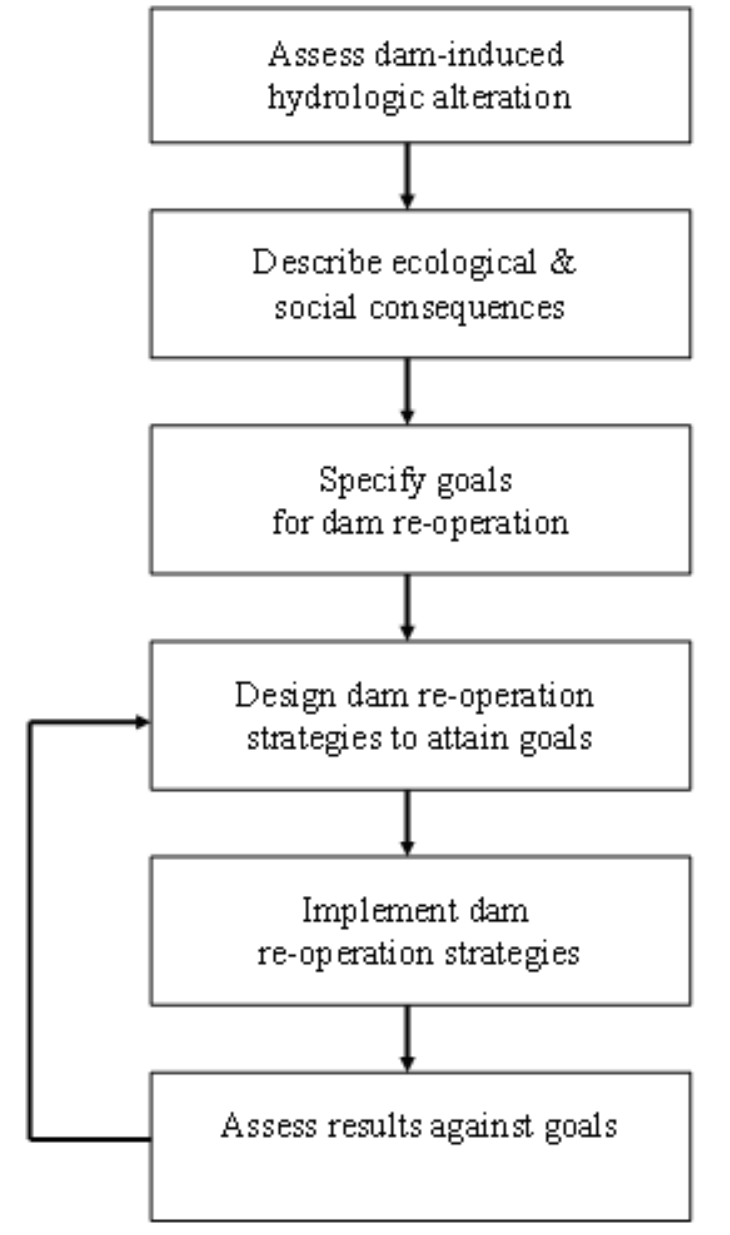
Fig. 4. Framework for planning and implementing a dam re-operation